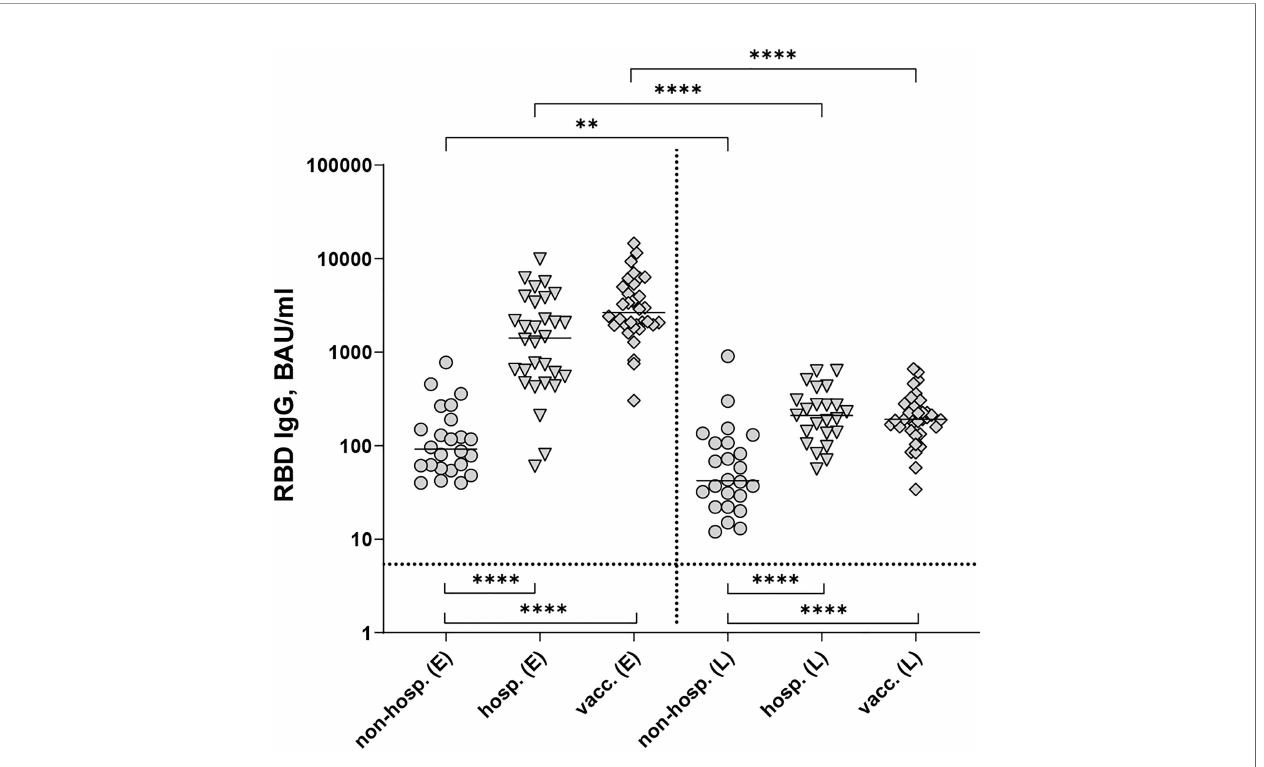
FIGURE 1 | SARS-CoV-2 RBD-speci fi c IgG antibodies after infection (non-hospitalized and hospitalized patients) and two doses of the mRNA vaccine BNT162b2. Early samples (E) were taken approximately three weeks after disease onset or the second vaccine dose; late samples (L) approximately six months after disease onset or the second vaccine dose. Bars indicate the median, the dotted horizontal line the cut-off of the assay. Statistical analysis was performed with the Kruskal- Wallis test and Dunn ’ s multiple comparisons post hoc test (comparison of cohorts, bottom brackets) or Mann-Whitney test (comparison within groups, top brackets). Asterisks indicate statistical signi fi cance: (**) = P ≤ 0.01, (****) = P ≤ 0.0001. non-hosp., non-hospitalized patients; hosp., hospitalized patients; vacc.,